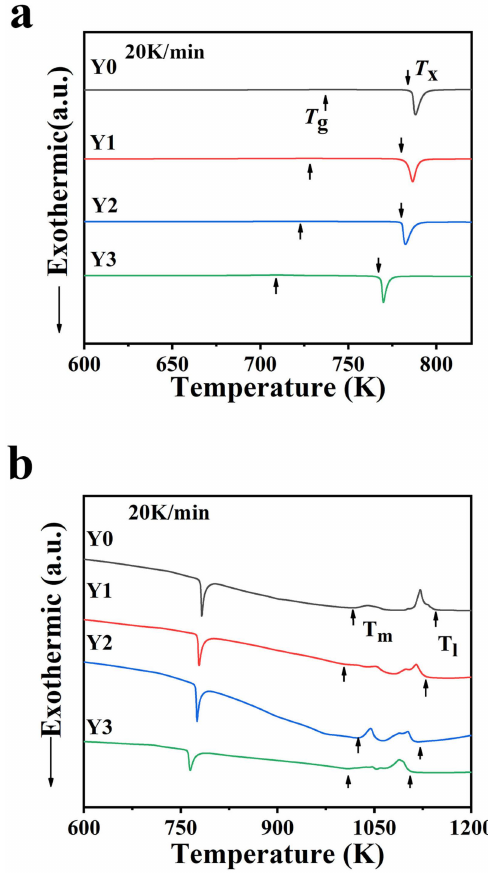
Figure 3. The ( a ) DSC and ( b ) high-temperature DSC curves of the Y0, Y1, Y2, and Y3 alloys.